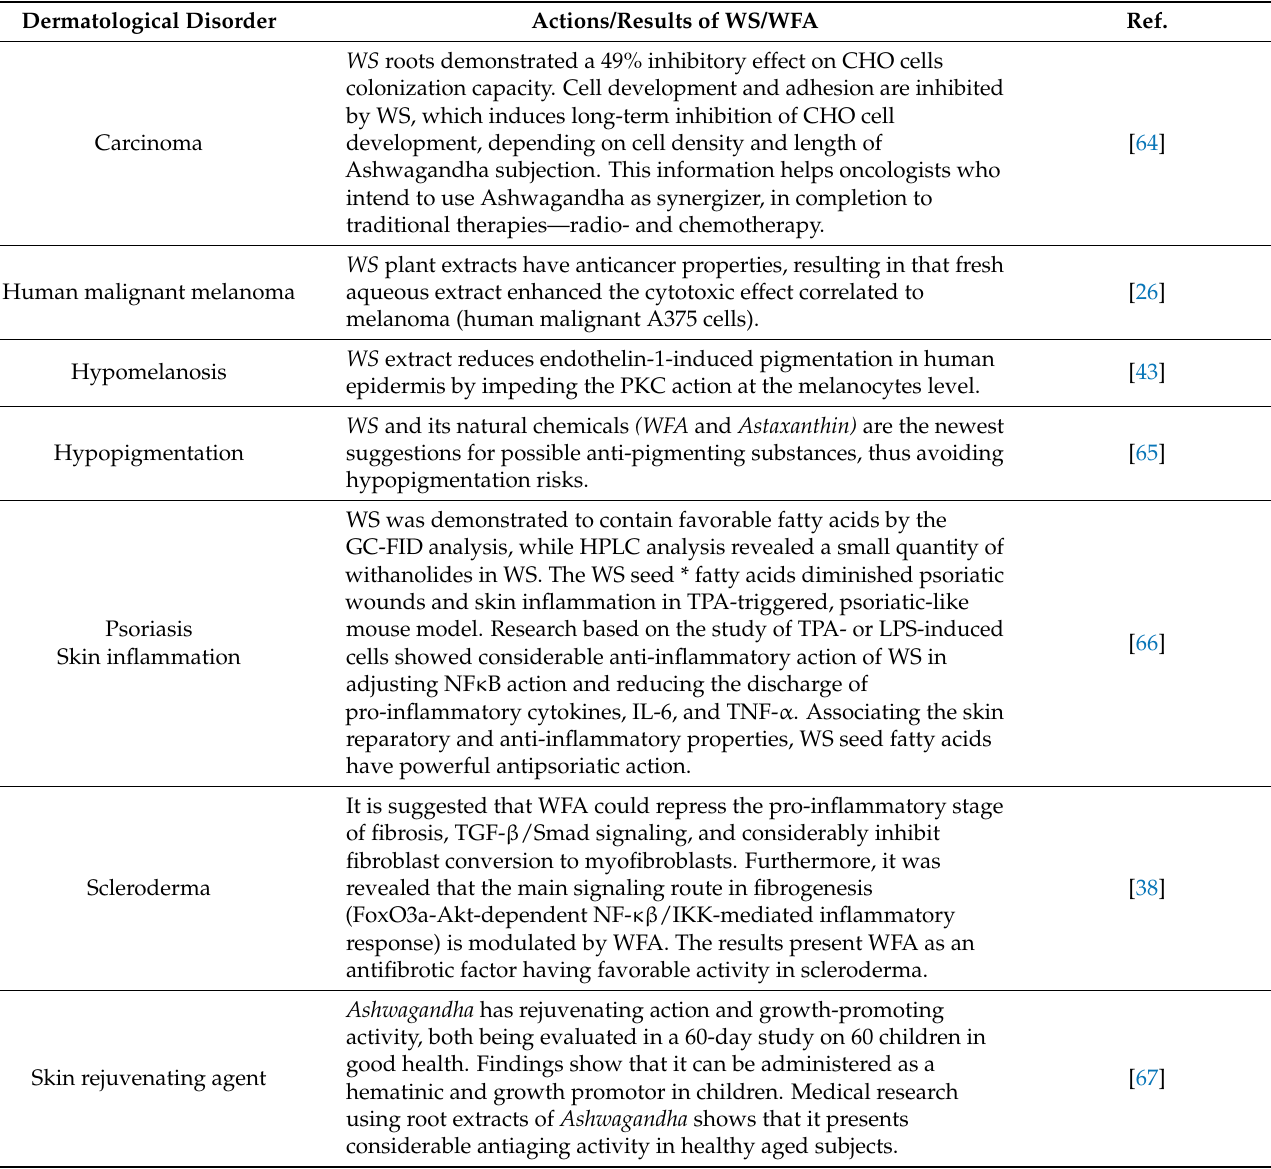
Table 2. WS root/seed extract usage in dermatological diseases and its actions and results. Dermatological Disorder Actions/Results of